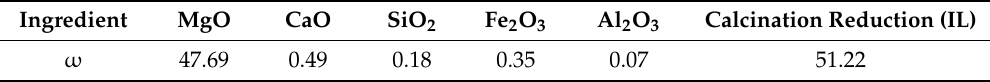
Table 1. Chemical composition of the concentrate